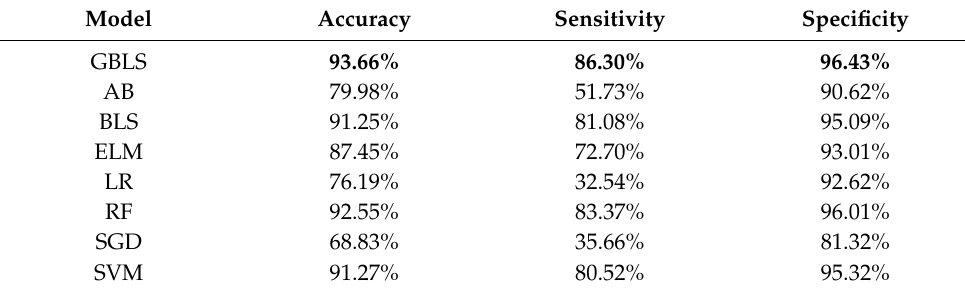
Table 4. Experimental results for landslide susceptibility